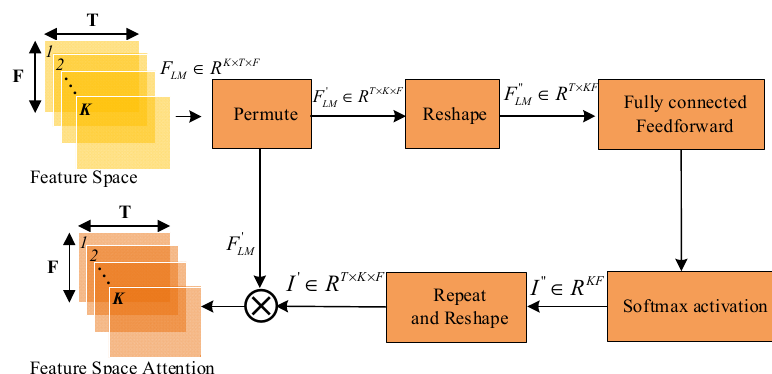
Figure 3. Feature space attention mechanism.